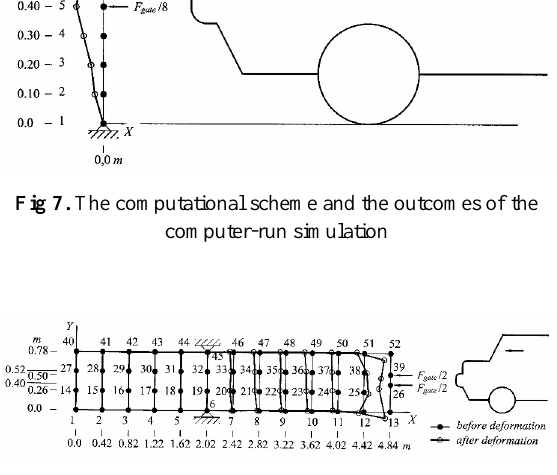
Fig 8. The computational scheme and the outcomes of the computer-run simulation